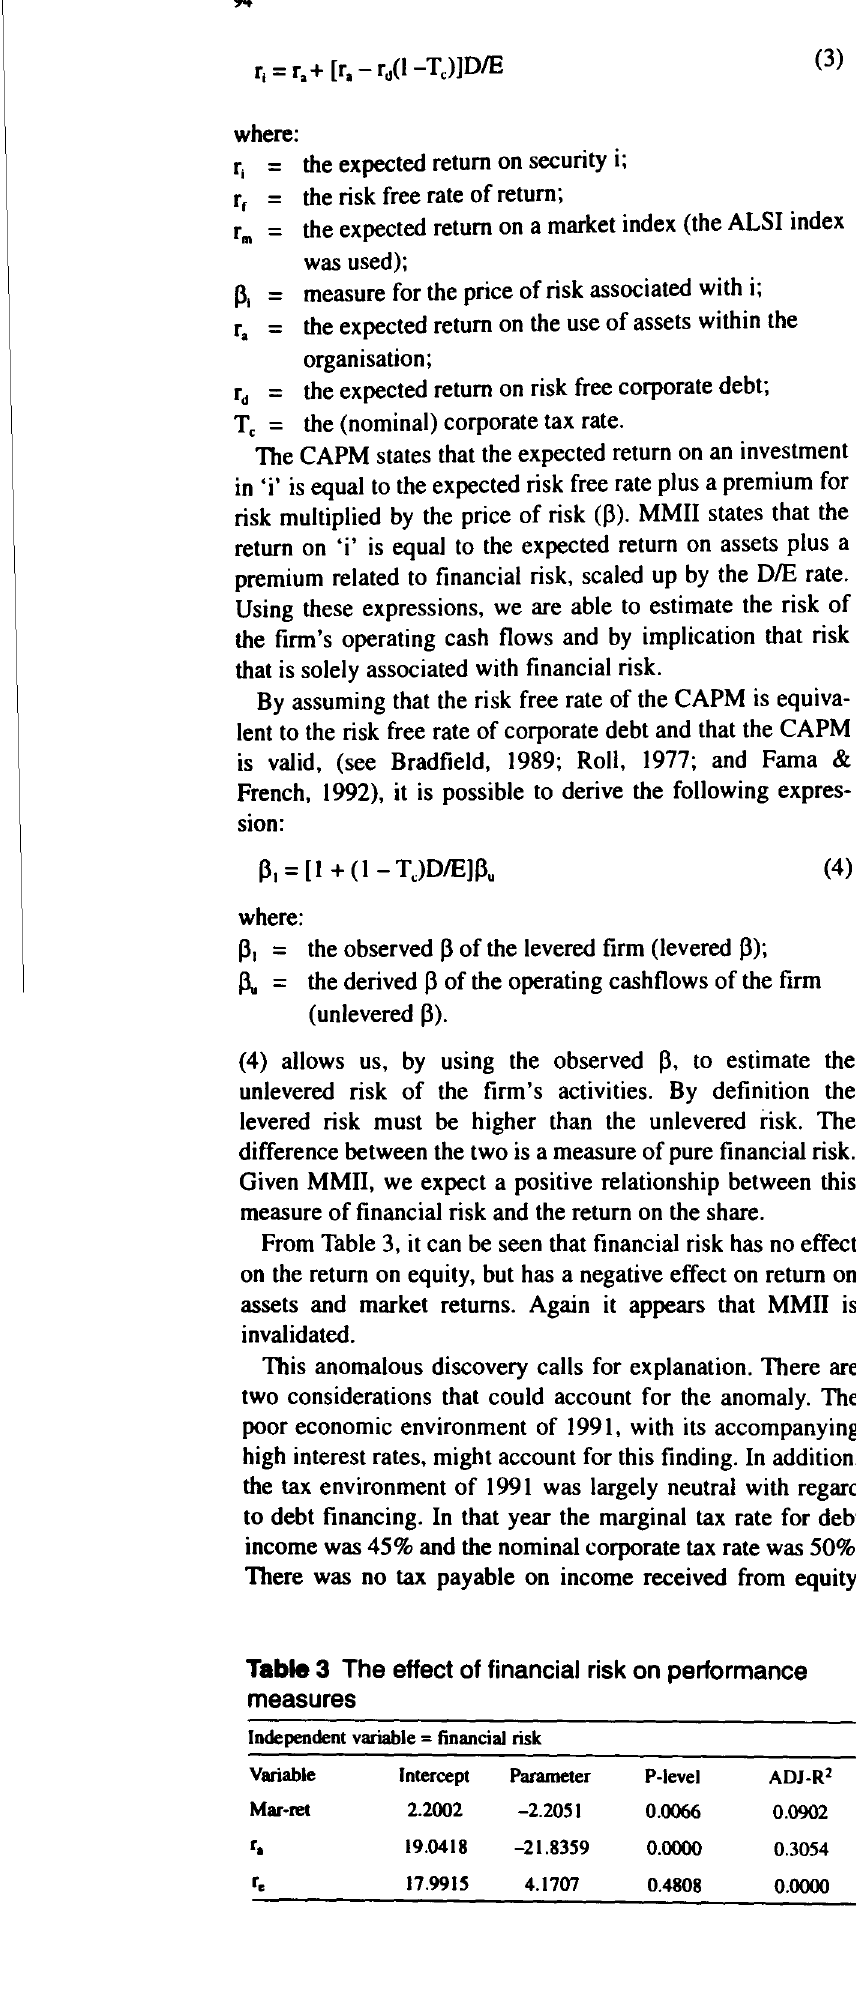
Table 3 The effect of financial risk on performance measures